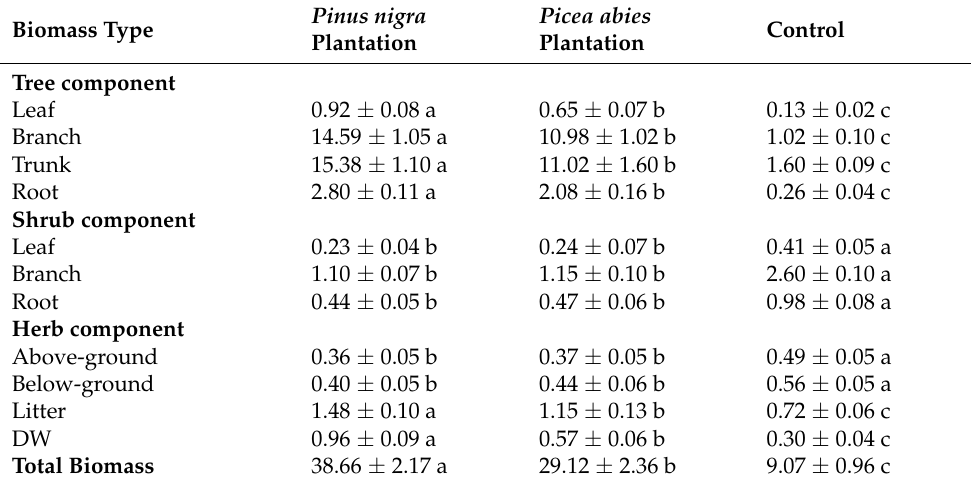
Table 6. Biomass (mean ± SD, Mg ha − 1 ) of trees, shrubs, herbs, litter, and deadwood (DW) by the allometric method.